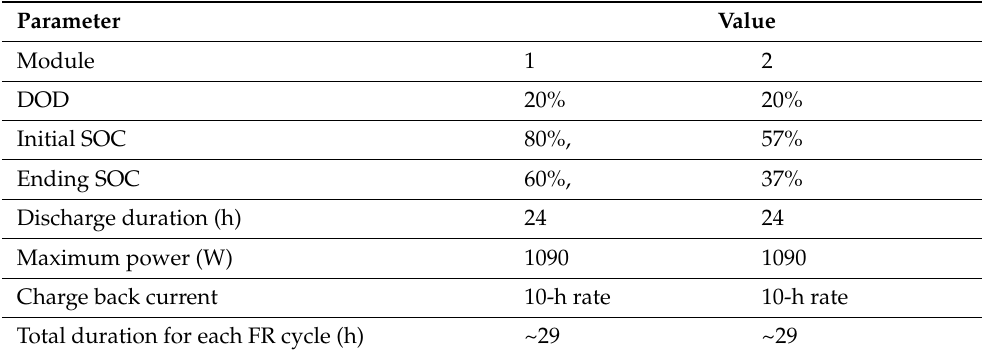
Table 3. Frequency regulation